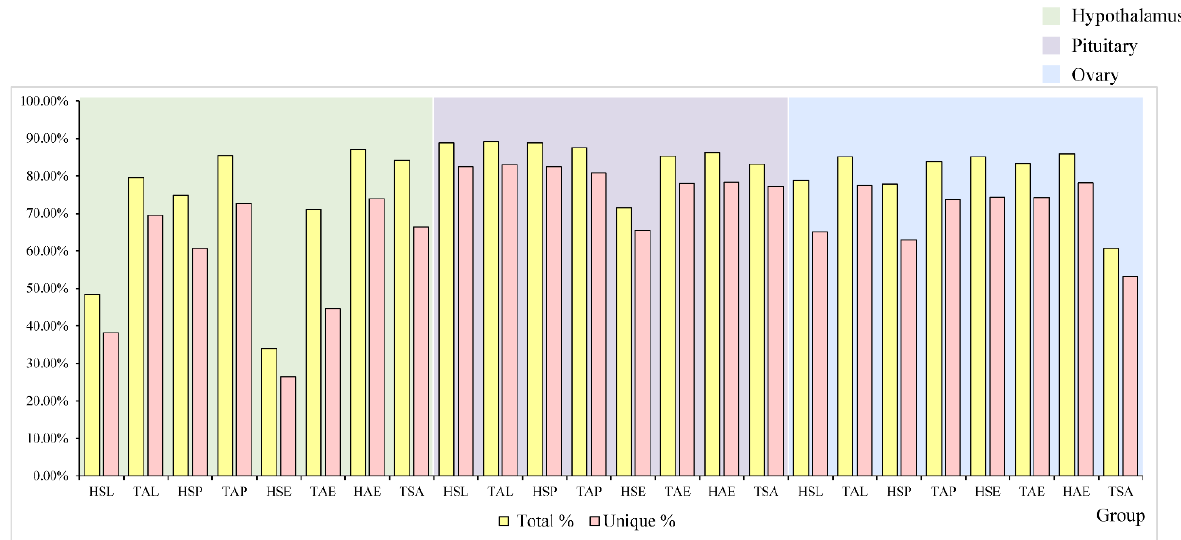
Figure 2. Total and unique mapped for each group in the hypothalamic, pituitary, and ovary.